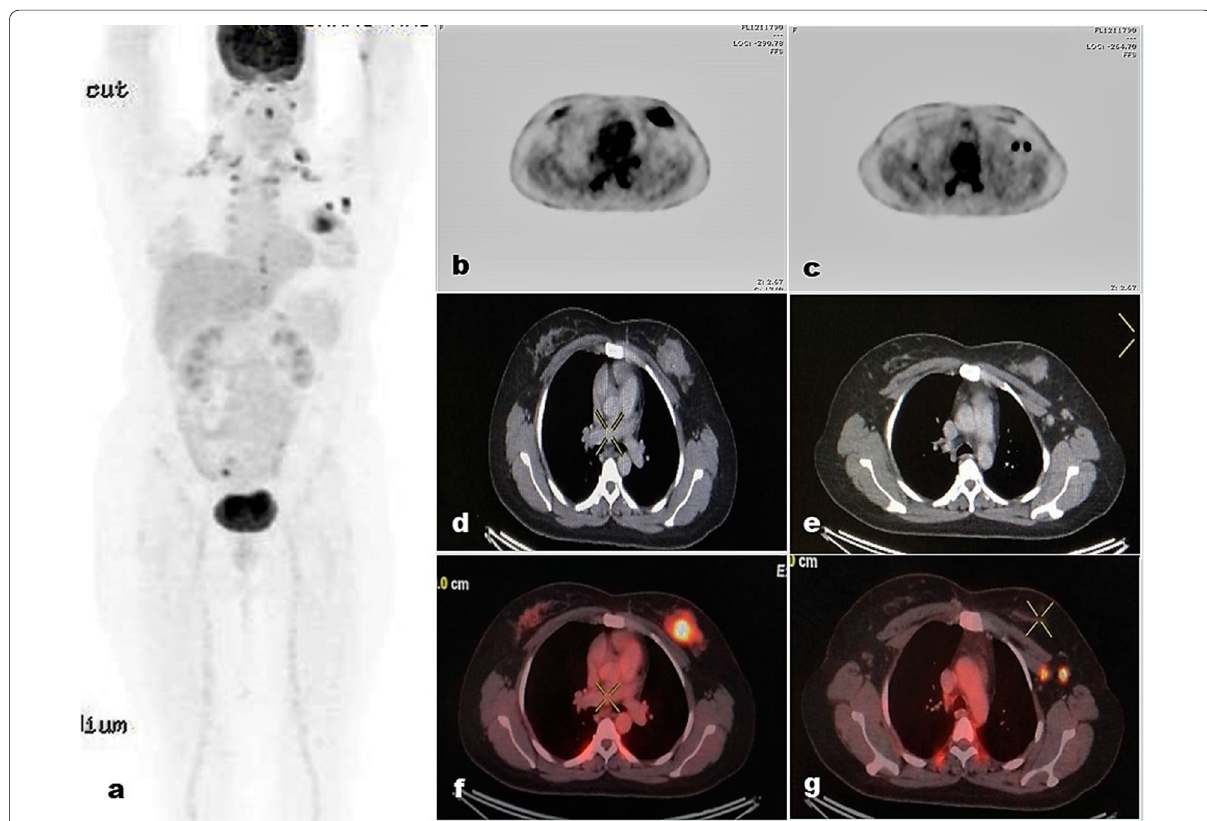
Fig. 1 43 years old patient with recently diagnosed left sided HER2 positive breast carcinoma. TLR 3.2 and TSR 3. a Maximum intensity = = projection. b and c Trans axial PET images corresponding axial CT cut in d and e shows left breast retro-areolar heterogenous enhancing soft tissue mass lesion with foci of calcifications. It measures about 5.5 3.5 cm associated with enlarged suspicious looking two left axillary lymph nodes. The × largest measures about 1 1.1 cm. f fused PET/CT axial cut shows left breast retro areolar FDG avid lesion displaying SUVmax ~ 9.3. g fused PET/CT × axial cut show two FDG avid axillary lymph node displaying SUVmax ~